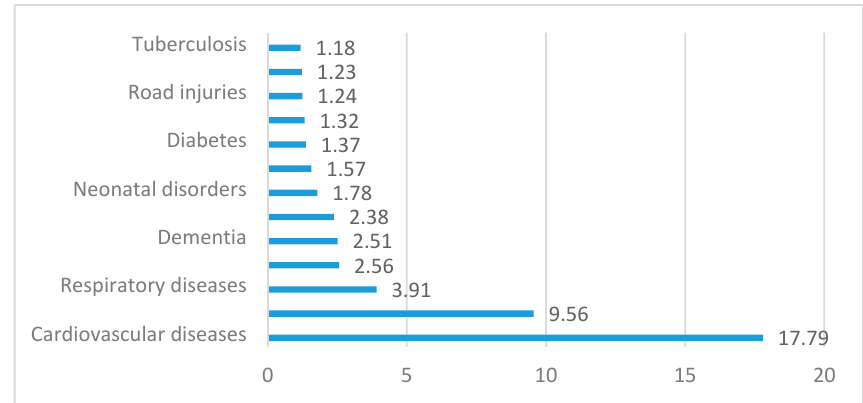
Figure 1. Number of deaths globally (million).